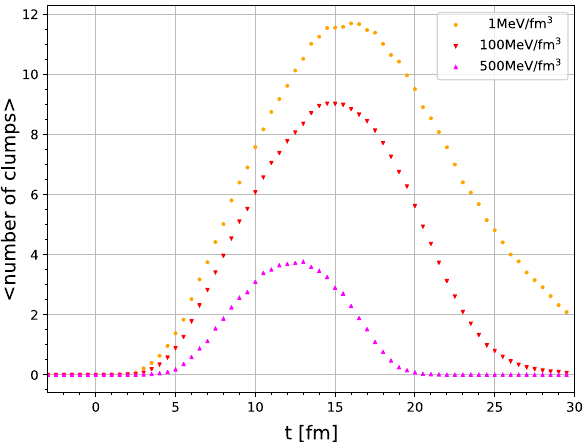
Fig. 20 Time evolution of the average number of connected regions (clumps) satisfying the constraints X ebe < 0 . 3 and Y ebe < 0 . 3 for the energy density thresholds ε > 1 , 100 or 500 MeV / fm 3 , in Au+Au collisions at E lab = 1.23 AGeV, 0–5% centrality class